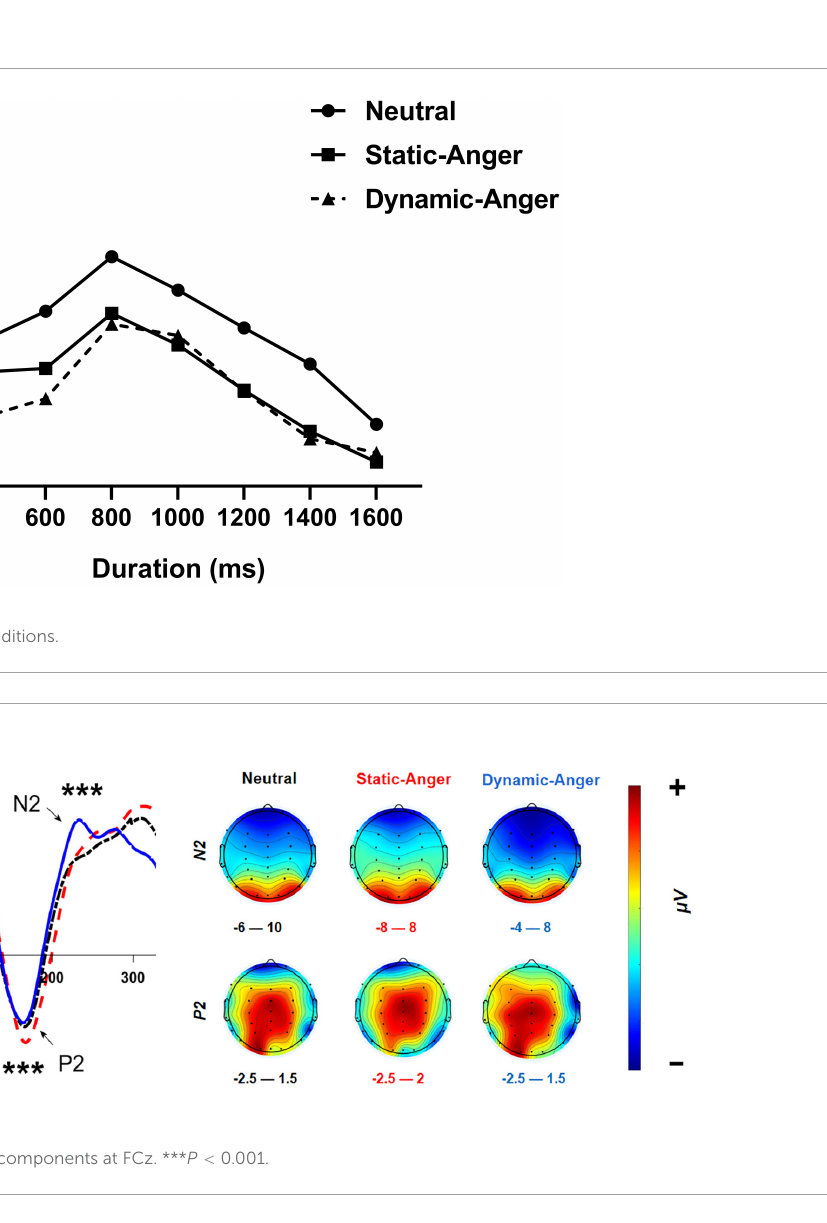
neutral faces, and static anger gradually increased significantly, with dynamic angry faces evoking significantly larger amplitude than neutral faces, neutral faces also induced significantly larger amplitude than static angry faces ( M DA = 3.96 ± 2.42 µ V; M SA = 4.84 ± 3.30 µ V; M NF = 6.07 ± 3.70 µ V; Figure 5